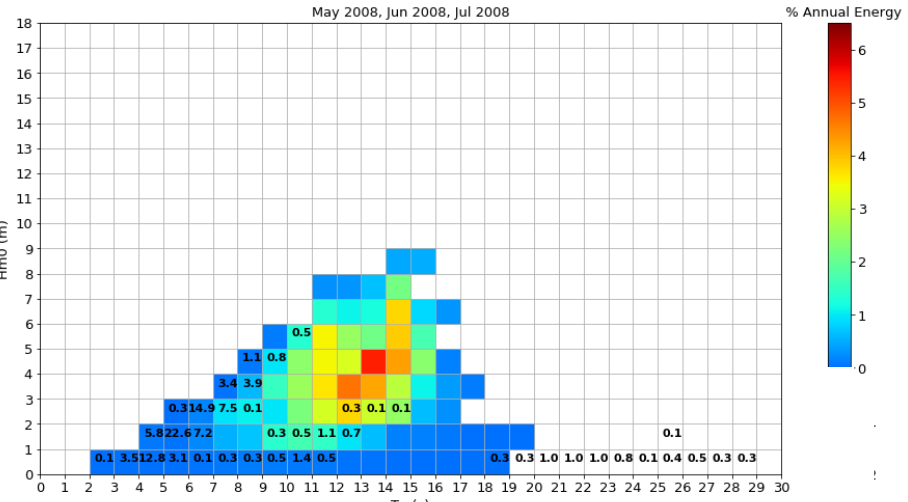
Fig 3. Scaled up South Arran ( H m0 , T p ) % occurrence scatter table (tabulated numbers) for May-Jul 2008 overlaid on Billia Croo ( H m0 , T p ) % annual incident energy scatter colour map for 2008.